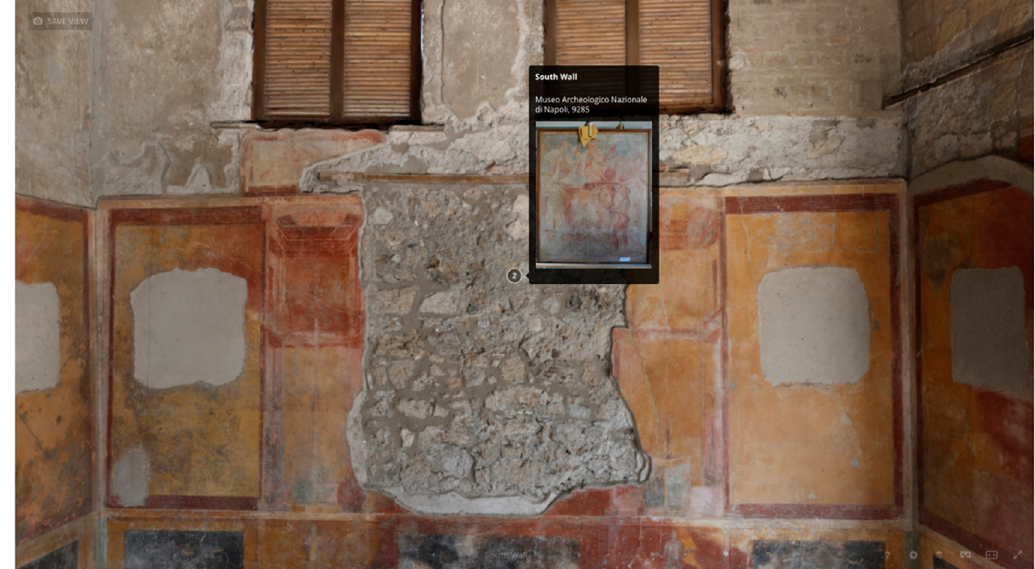
Figure 10. Room 16, south wall. Screenshot showing the interactive 3D model in SketchFab, with the embedded wall paintings from the Museo Archeologico Nazionale di Napoli on concession of the Ministero dei Beni e delle Attività Culturali e del Turismo, Parco Archeologico di Pompei . Model Courtesy: Kelly McClinton. Image Courtesy: photos for the 3D model on concession of the Ministero dei Beni e delle Attività Culturali e del Turismo, Parco Archeologico di Pompei (used by permission).